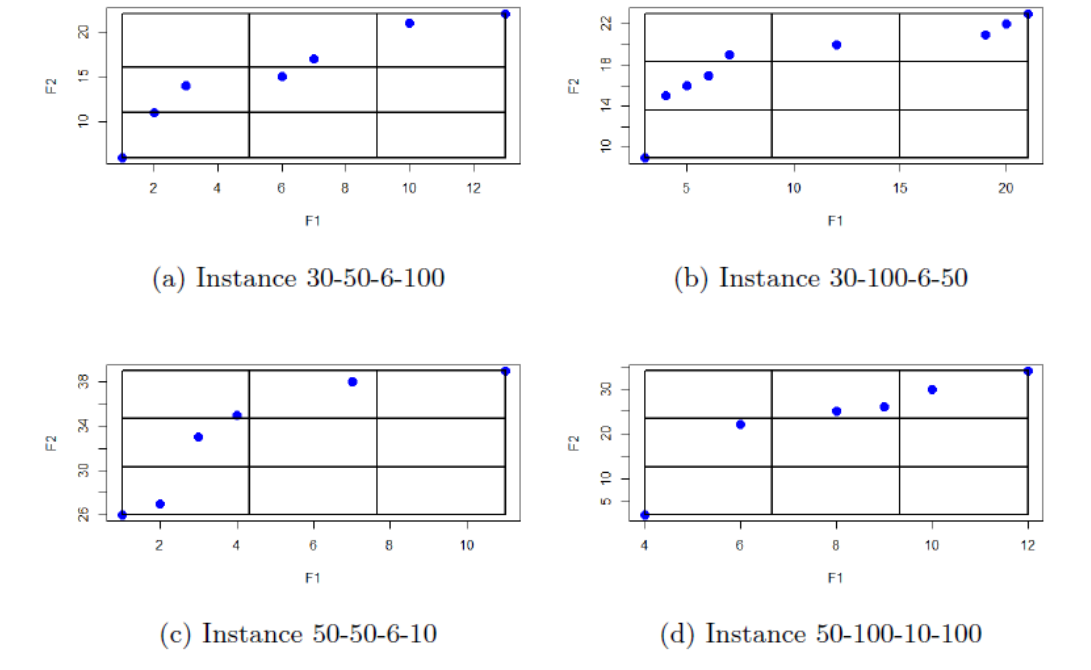
Figure 1. Selected approximated Pareto fronts obtained by the BONXEA.